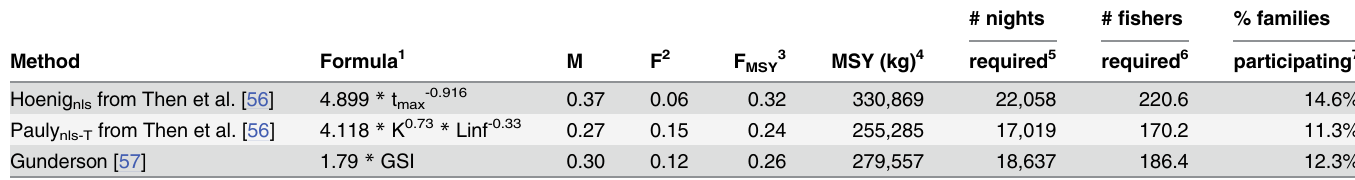
Table 1. Natural mortality rates estimated by life history invariant methods and estimates of the effort required to exceed the sustainable harvest associated with each mortality